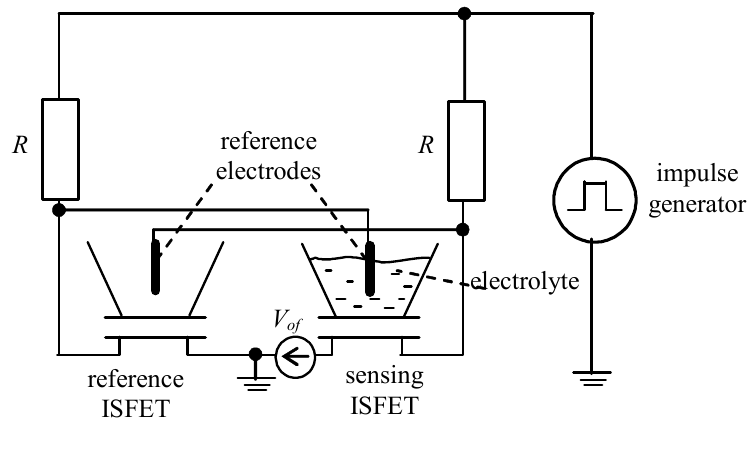
Figure 2. Flip-flop circuit with ISFETs.